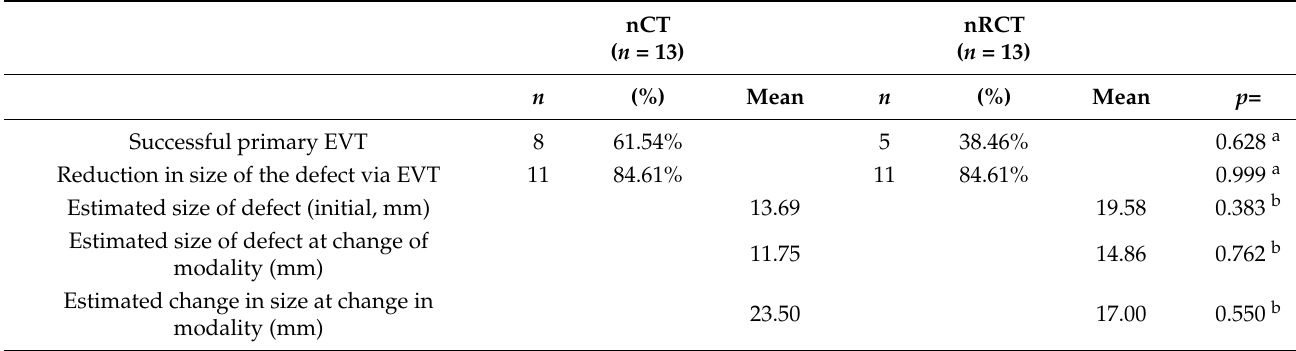
Table 4. EVT failure and reasons for change in